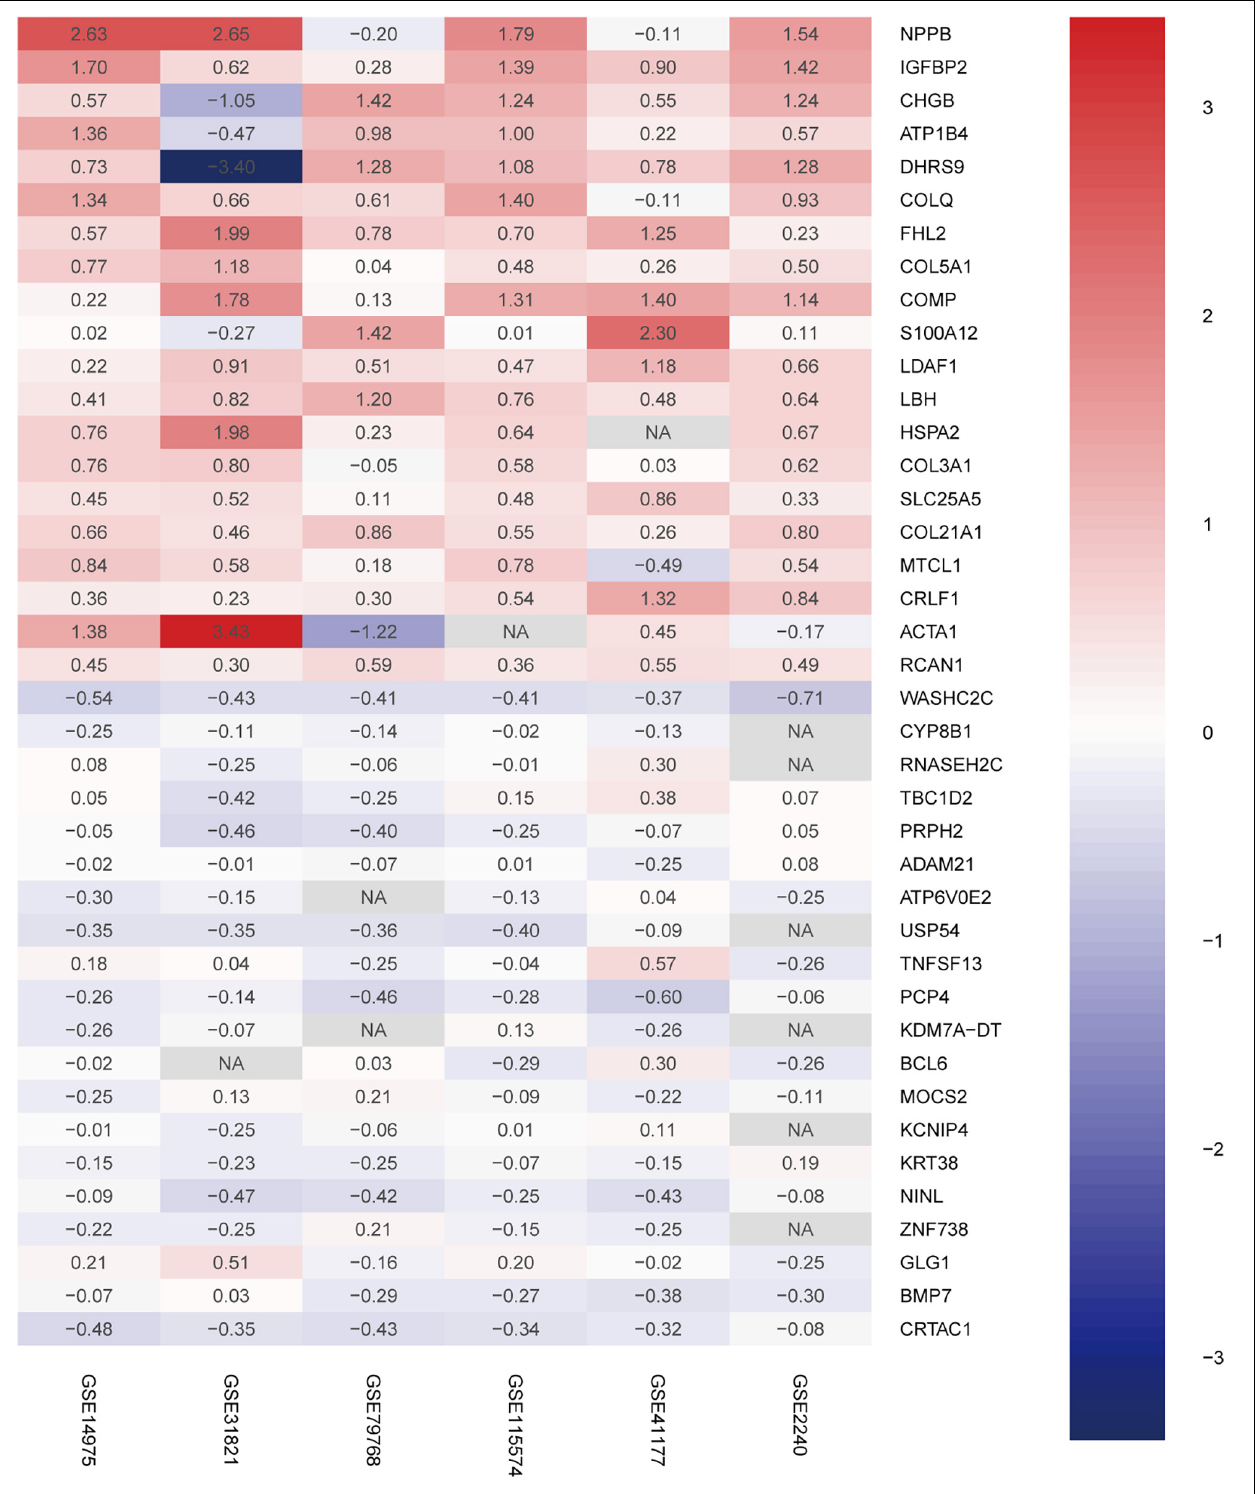
Frontiers in Cardiovascular Medicine |